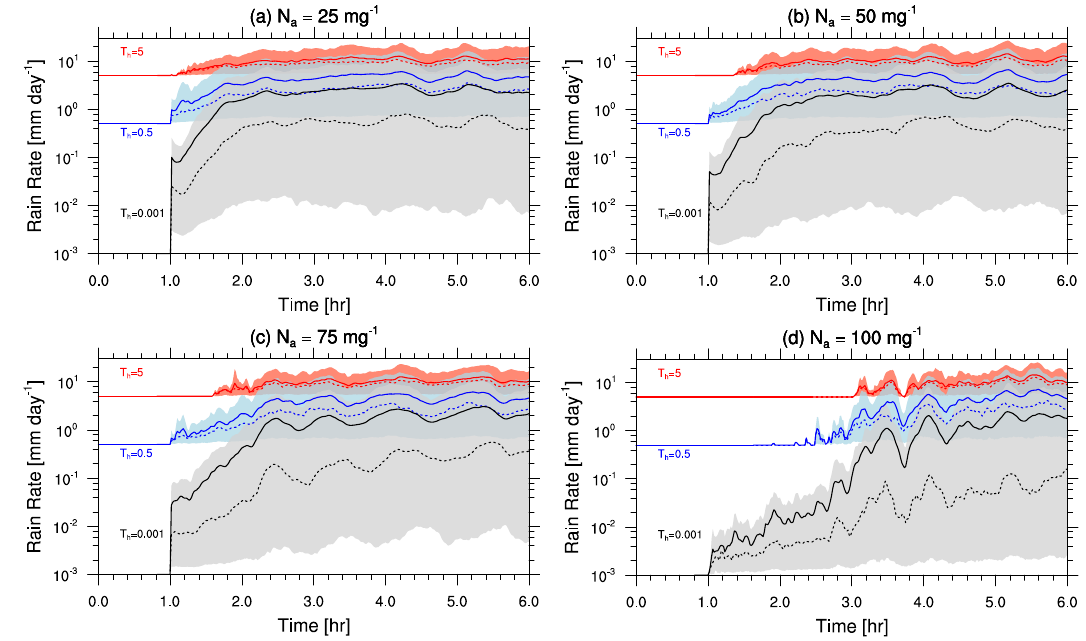
Figure 2. Mean (solid) and median (dashed) rain rates for the three rain rate thresholds – T h of 0.001 (gray), 0.5 (blue), and 5 (red) mmday − 1 – for four different aerosol loadings. The shaded region encompasses the 10th percentile to the 90th percentile. R is depicted as equal to T h for the first hour as a reference point for the minimum R that is possible under each T h condition. The model output is for the DYCOMS-II